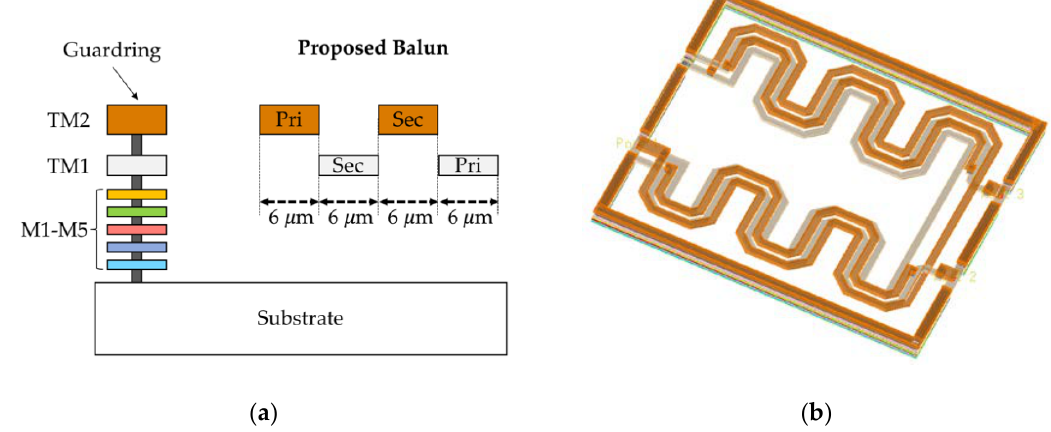
Figure 5. ( a ) Cross-section view of the metal stack and proposed balun; ( b ) 3D view of the balun.